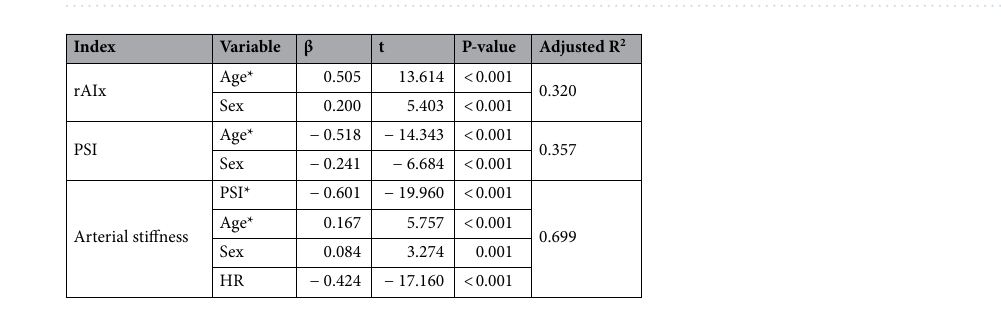
Table 2. MLR analyses of the rAIx and PSI according to age and sex and of arterial stiffness, inferred by the rAIx, according to the PSI, age, sex and HR. *Tested by log